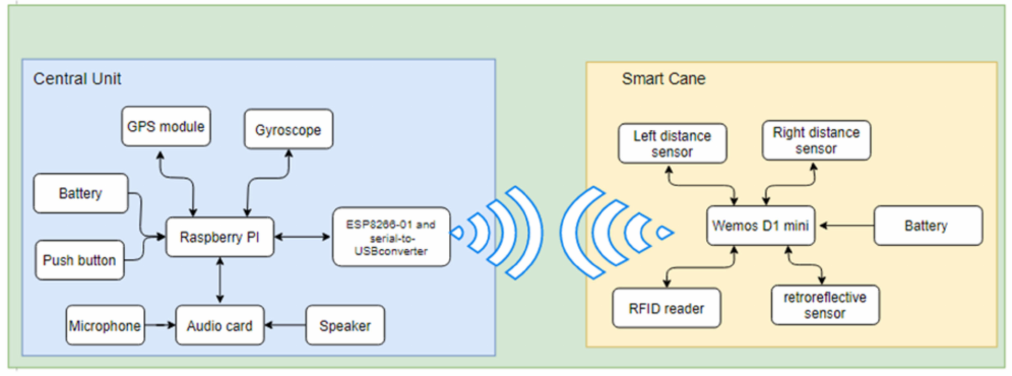
Figure 1. Hardware parts of the smart assistant: the central unit and the smart